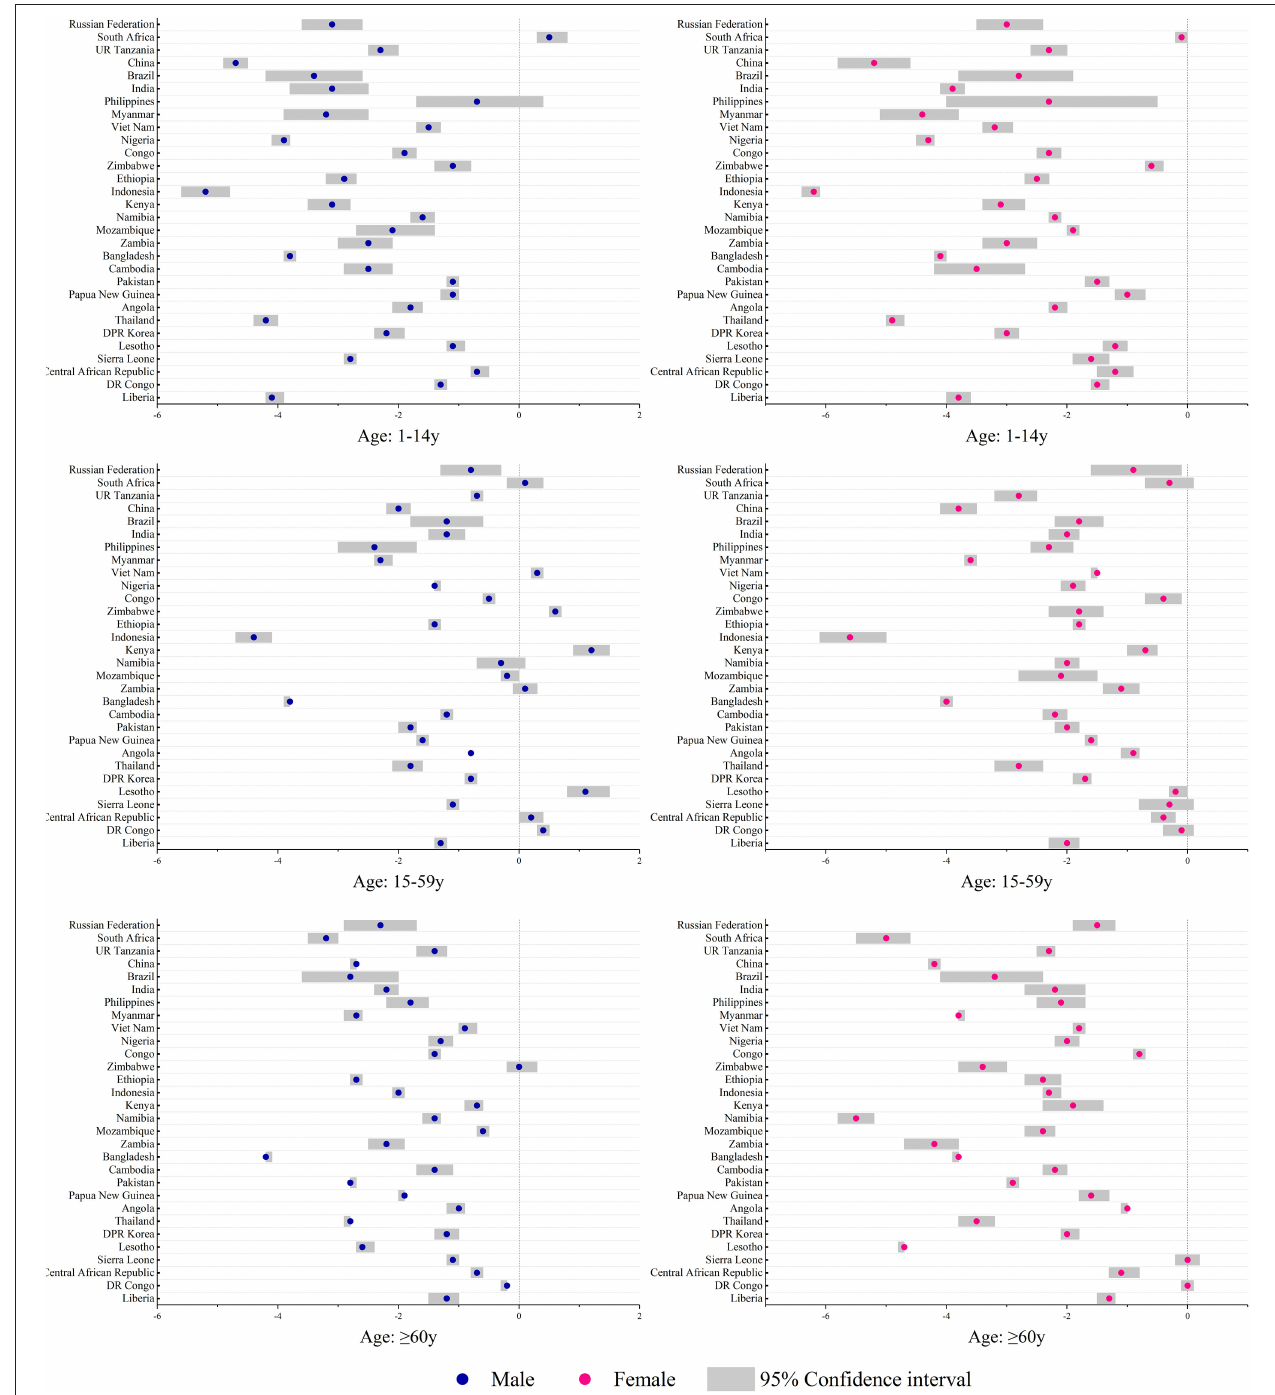
FIGURE 3 | Average annual percent changes of incidence by different age and sex groups in the 30 HBCs, 1990–2019. HBC, high burden country.